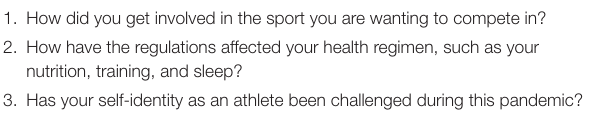
TABLE 2 | Sample interview